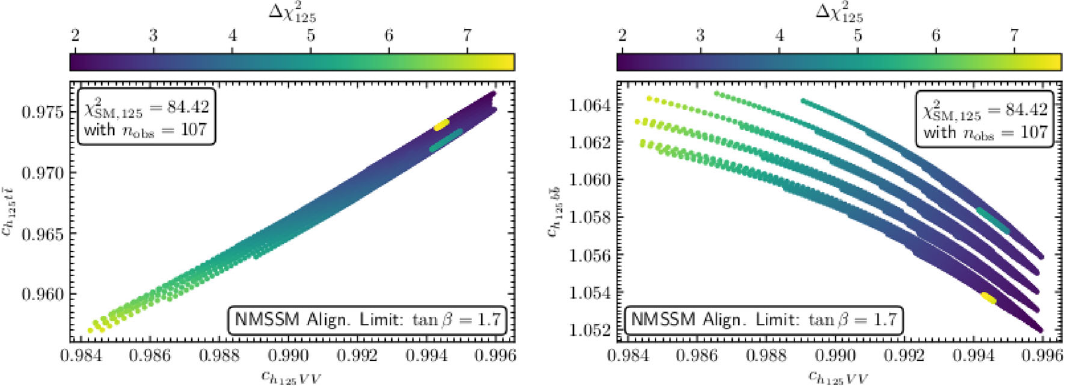
Fig. 21 NMSSM parameter points with χ 2 ≤ χ 2 indicate the values of (cid:14)χ 2